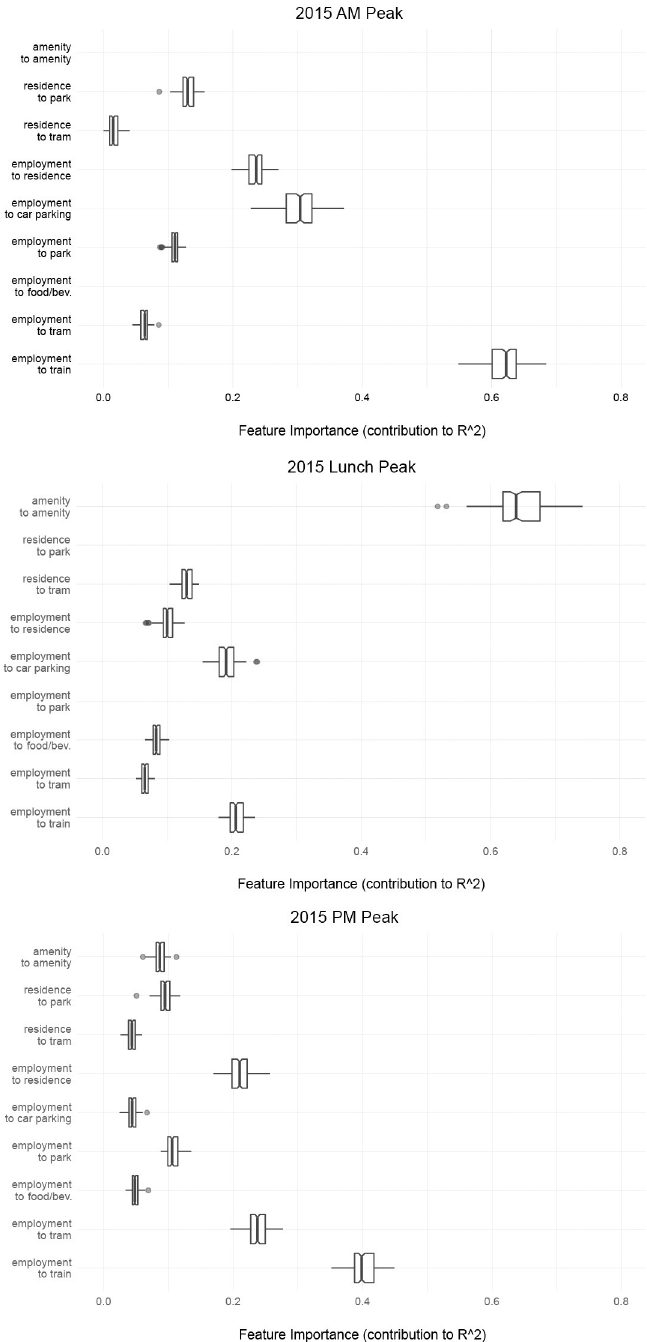
Fig 6. Effect of pedestrian flow measures on model predictions without sensor-level dummies during AM peak, Lunch peak, and PM peak.